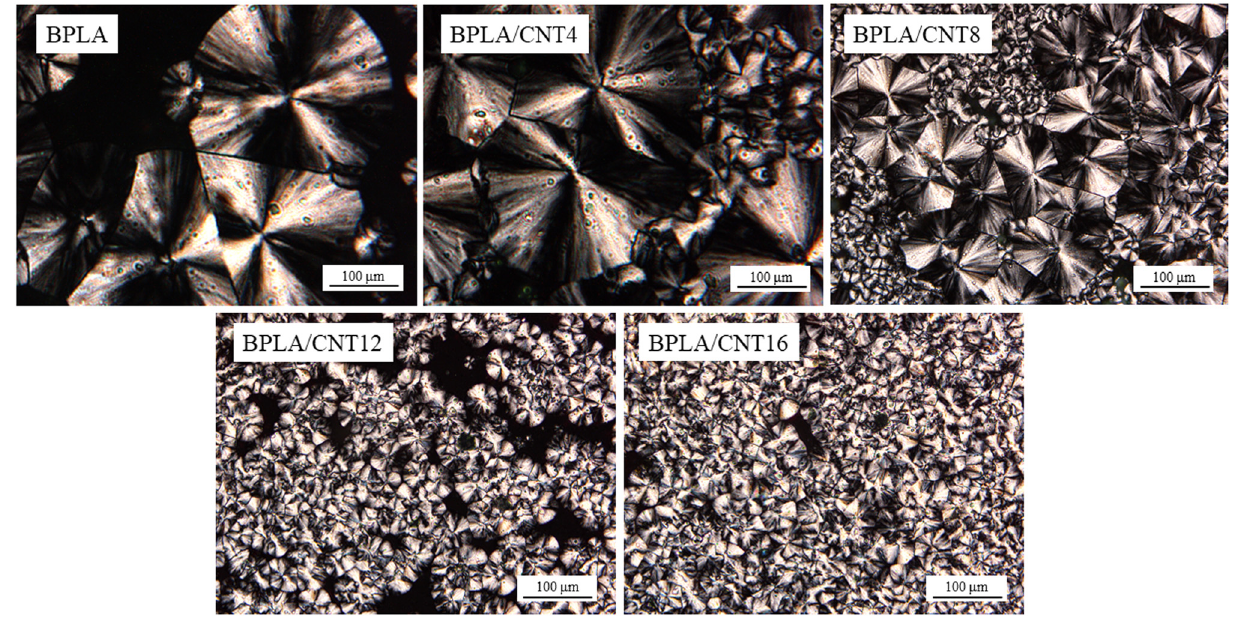
Figure 4: POM images of BPLA/CNT